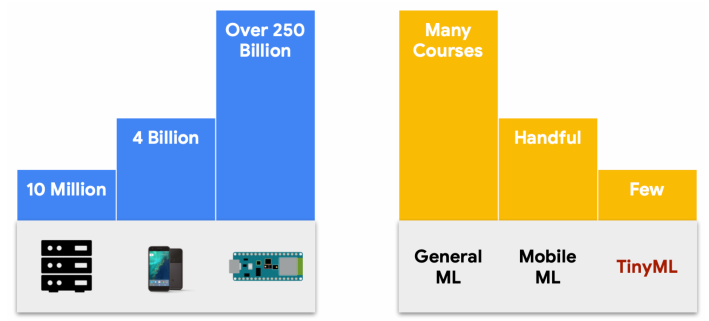
Figure 4. The number of courses is disproportionate to the number of